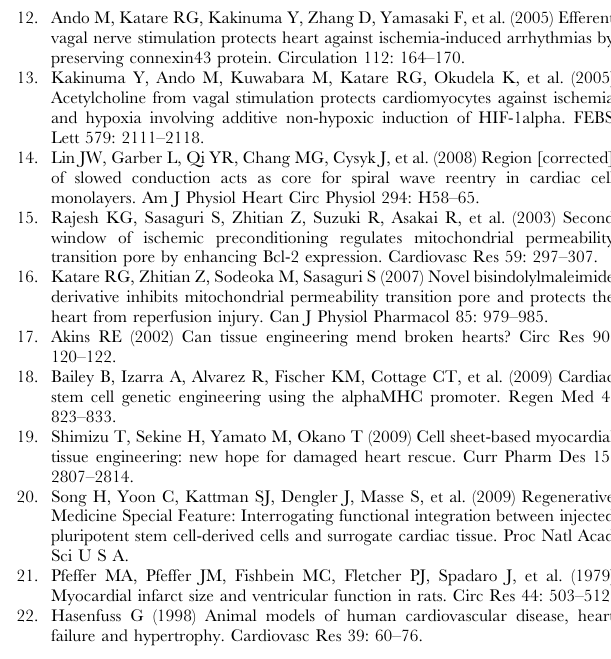
Figure S1 Mechanical stretch synchronizes the contraction of engineered heart tissue. Found at: doi:10.1371/journal.pone.0009275.s001 (2.18 MB TIF) Video S1 Video demonstrating the construction of engineered heart tissue. Found at: doi:10.1371/journal.pone.0009275.s002 (1.78